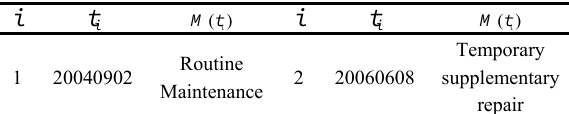
Figure 3 Actual Performance Graph of Track Gauge at Mileage Point K423+606 in Jing-Hu Down-going Track Table 7 Time Series of Maintenance Time at Mileage Point K423+725 in Jing-Hu Down-going Track